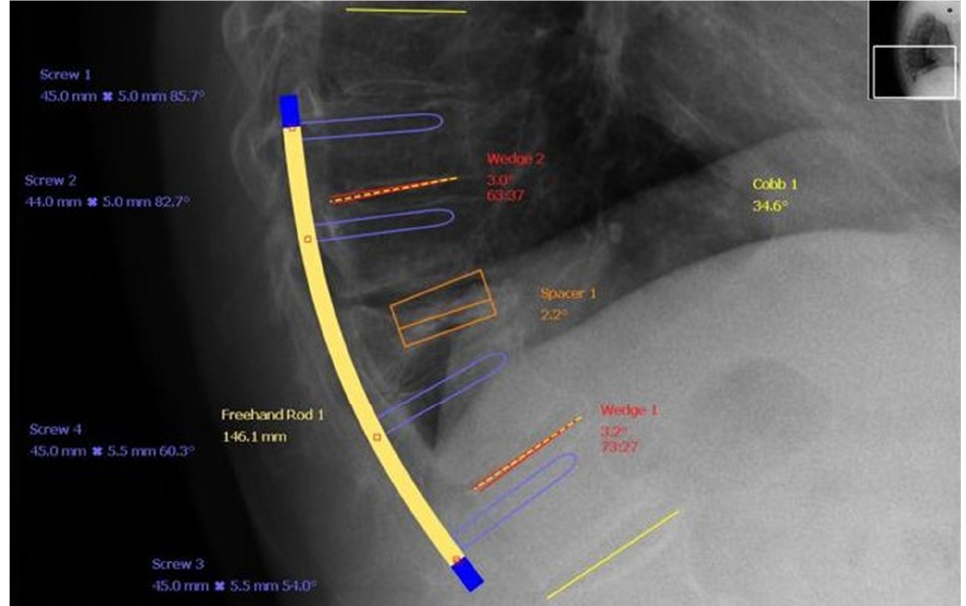
Figure 2. A preoperative visualisation of the effects of MIS treatment for KD developed from OVCF after an ineffective use of conservatice regimen. J. Clin. Med. 2021 , 10 , x FOR PEER REVIEW